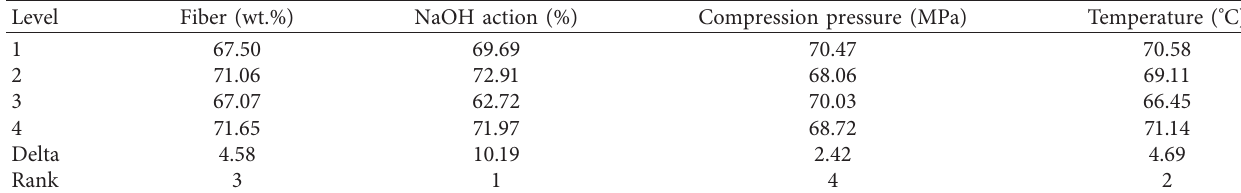
Table 3: Response table for means (flexural strength).